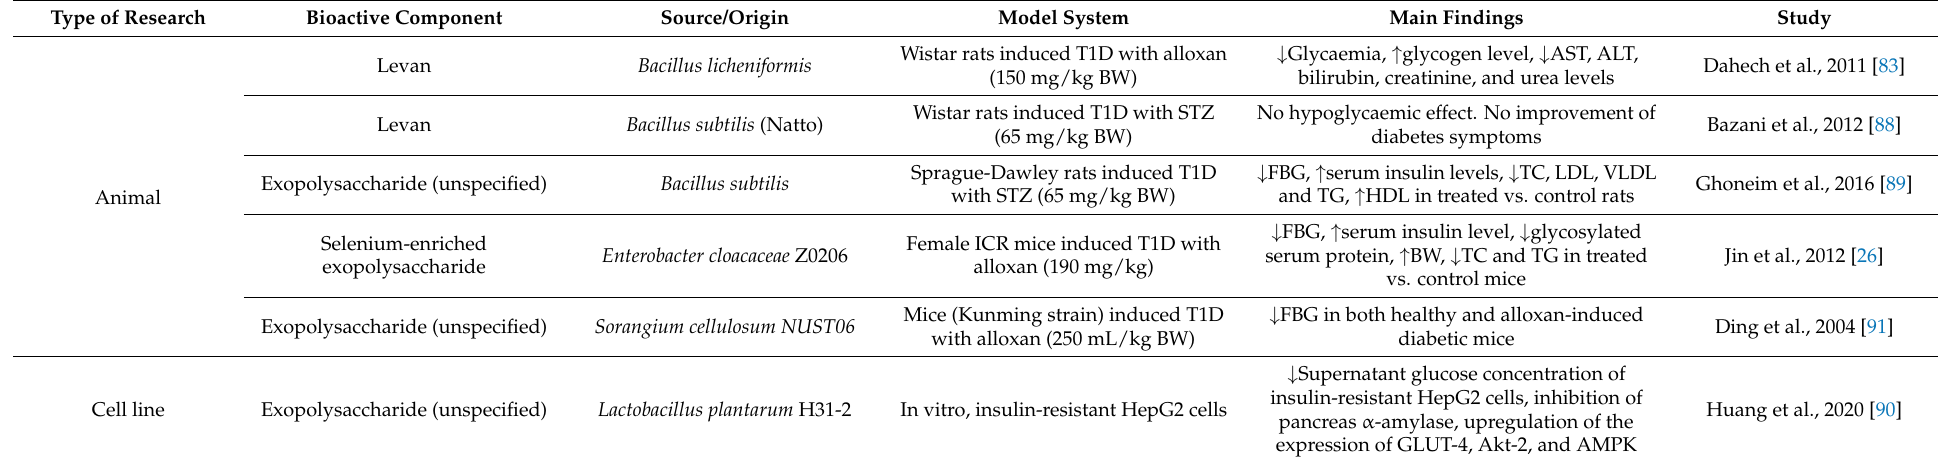
Table 1. Experimental studies on microbial exopolysaccharides in diabetes